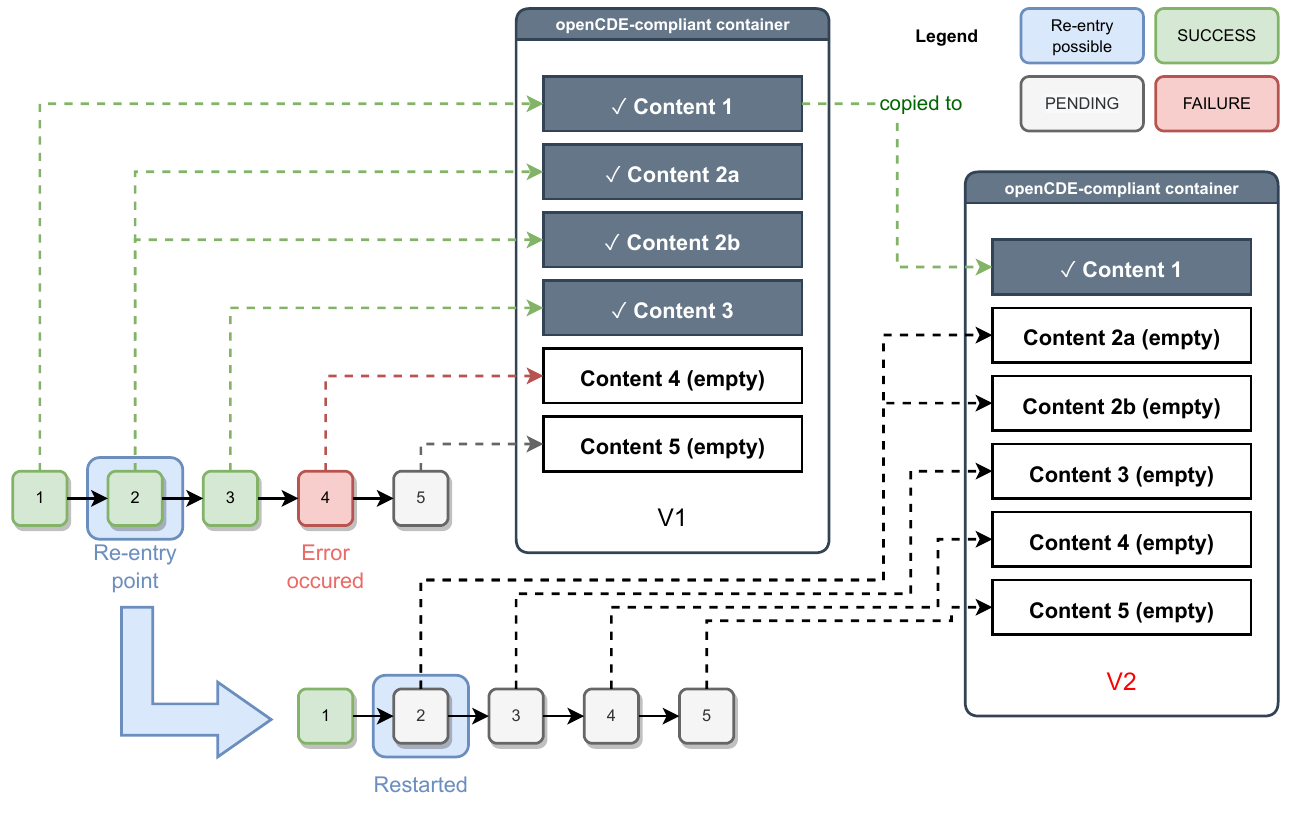
Figure 7. Interaction between toolchain and openCDE-compliant data storage during